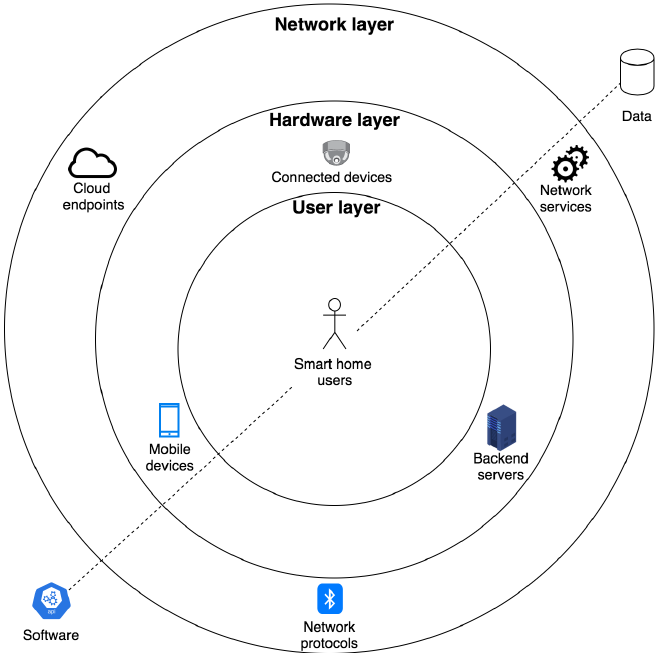
Figure 1. The components of a smart home. At the center are the users, particularly the smart home residents. Users interact with their home via the hardware layer, typically through mobile devices. The network layer is responsible for implementing the communication and providing connectivity between the users and their homes. Data and software represent crosscutting components as data are generated, collected, processed, and exchanged at different layers, and software, which can include machine learning models, is integrated in the different conceptual